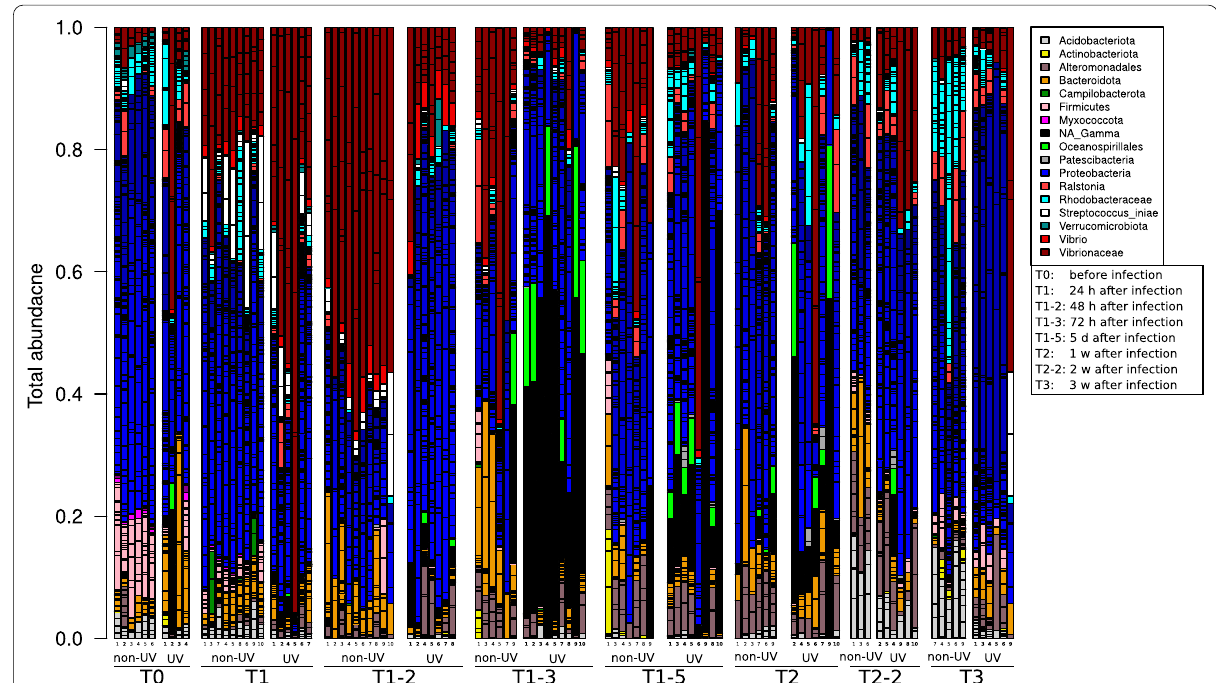
Fig. 6 Bar graph illustrating relative abundances of different bacterial phyla (different colors). Each bar represents one (tagged) fish, at different time points